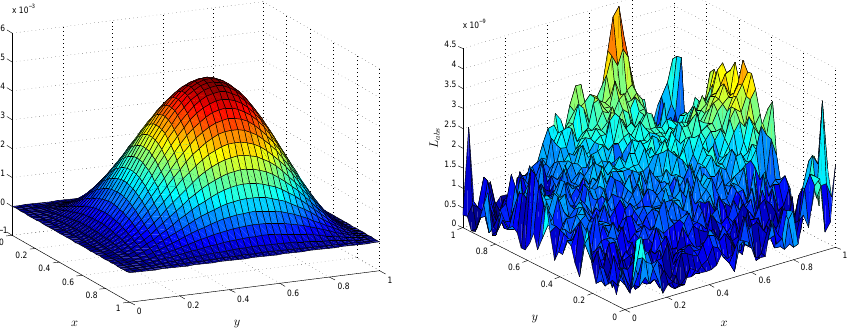
Figure 10. Numerical approximation ( left ) and L abs error norm ( right ) for Problem 4 for N =